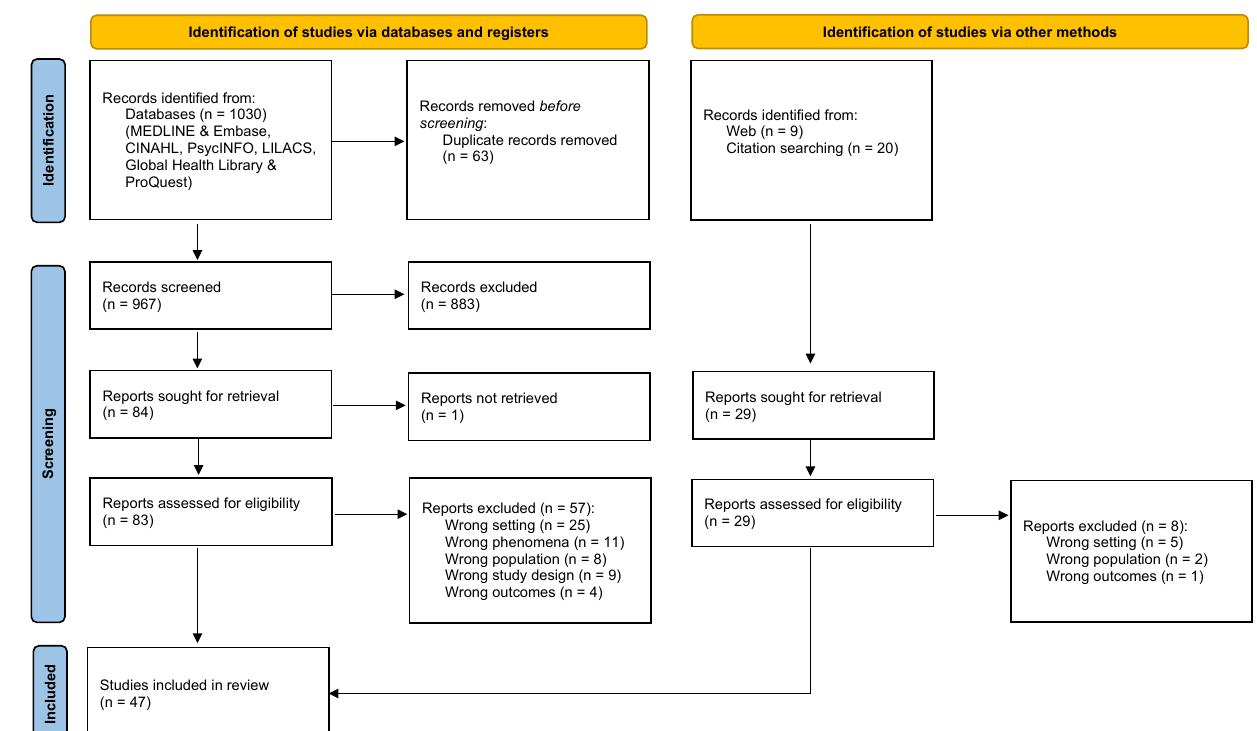
Figure 3: PRISMA Flowchart